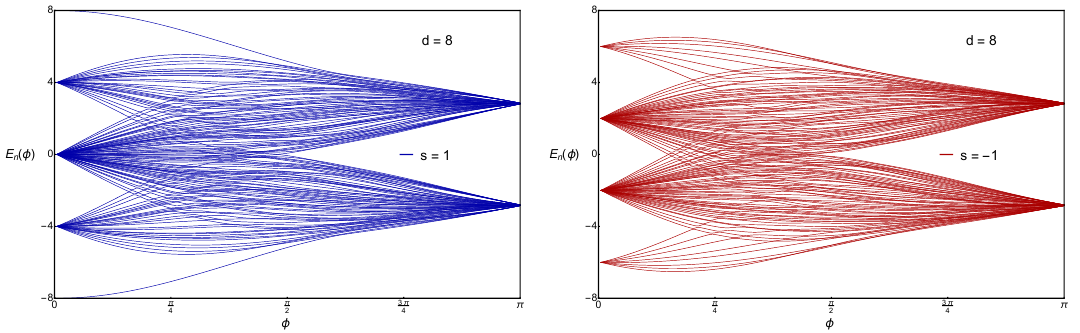
Figure 2 . Spectral flow of the hypercubic Model as a function of the flux φ . For each of its two symmetry classes. To make individual curves visible, we show the results for d = 8 , but the features for larger values of d are